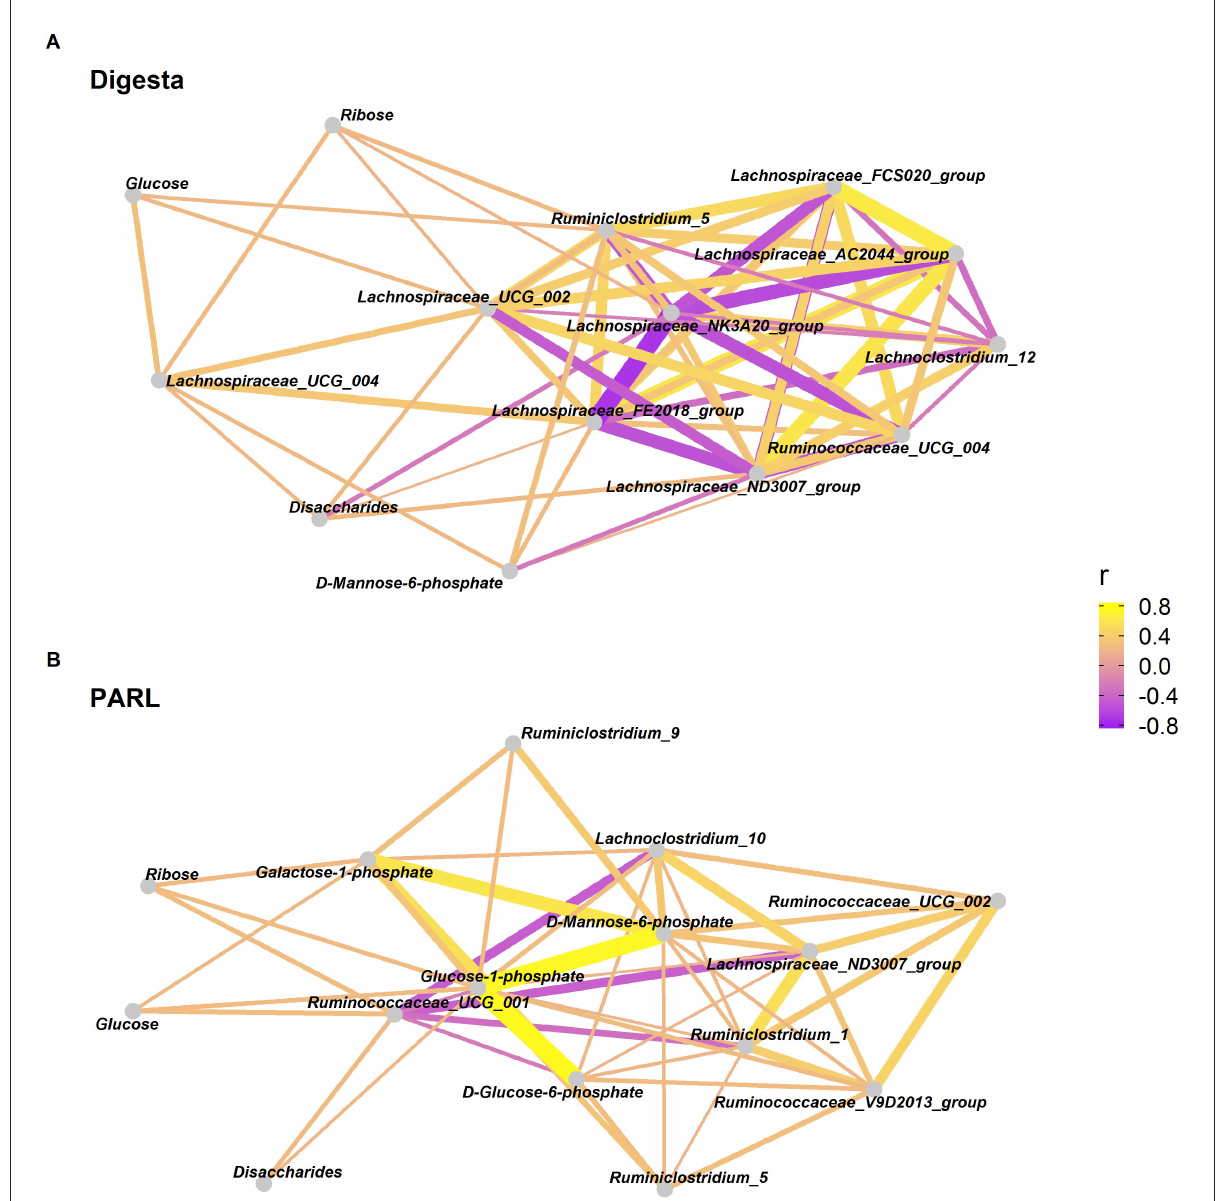
FIGURE8 Network analysis based on Spearman correlations between carbohydrates and microbes in the rumen. Correlations were calculated between genera belonging to families Lachnospiraceae and Ruminococcaceae and carbohydrates in (A) solid digesta (Digesta) and (B) particle associated rumen liquid (PARL). Correlation coefficients are indicated by color (purple = negative, yellow = positive) and line